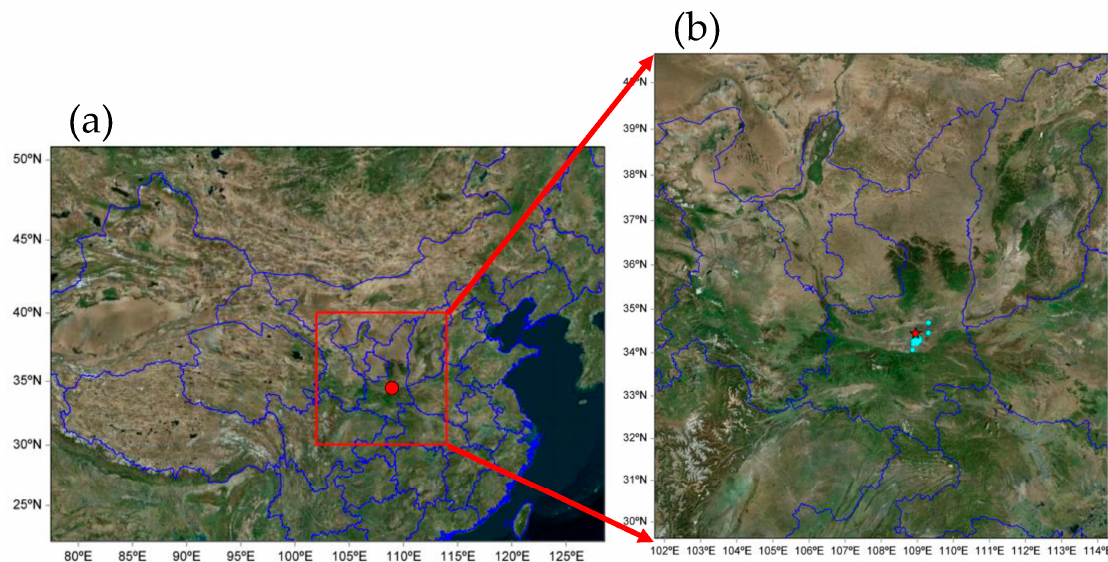
Figure 1. Geographic location of Xi’an ( a ) and air quality forecast range ( b ), where the red point is the location of the Jinghe station in Xi’an, and the blue point is the location of the PM 2.5 monitoring